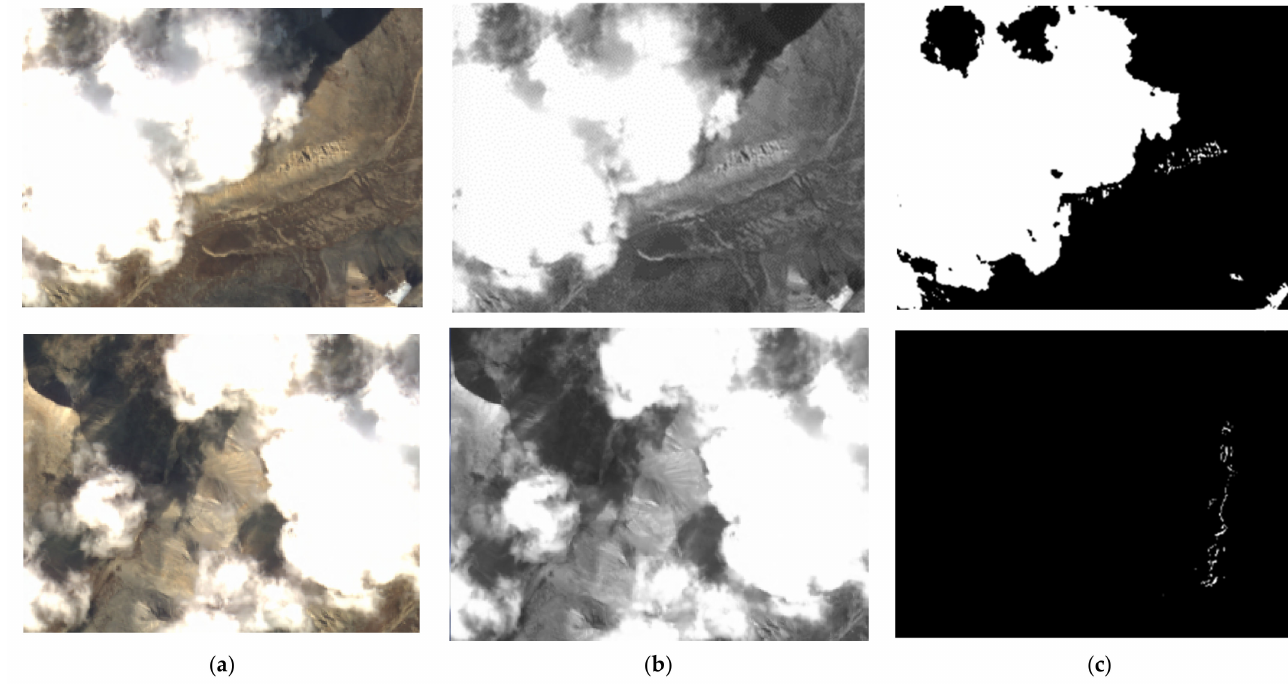
Figure 1. The segmentation examples of the Otsu algorithm. ( a ) Cloud; ( b ) binarization image; ( c ) segmentation